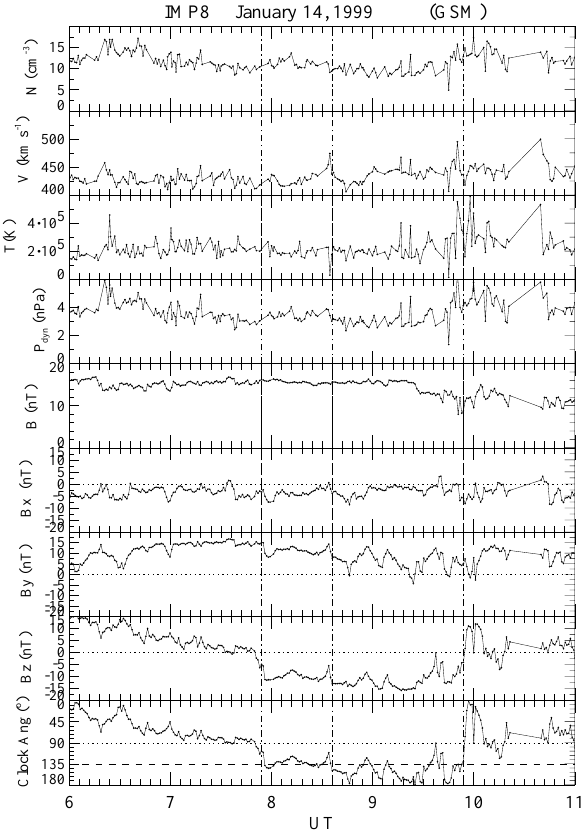
Fig. 1. Interplanetary magnetic field (IMF) and solar wind plasma data obtained from spacecraft IMP8 during the interval 06:00– 11:00UT on 14 January 1999. Panels from top to bottom show proton density, bulk speed, proton temperature, dynamic pressure, field intensity, and GSM X , Y , and Z components, and the clock angle. IMF regimes are marked by vertical guidelines (see text).